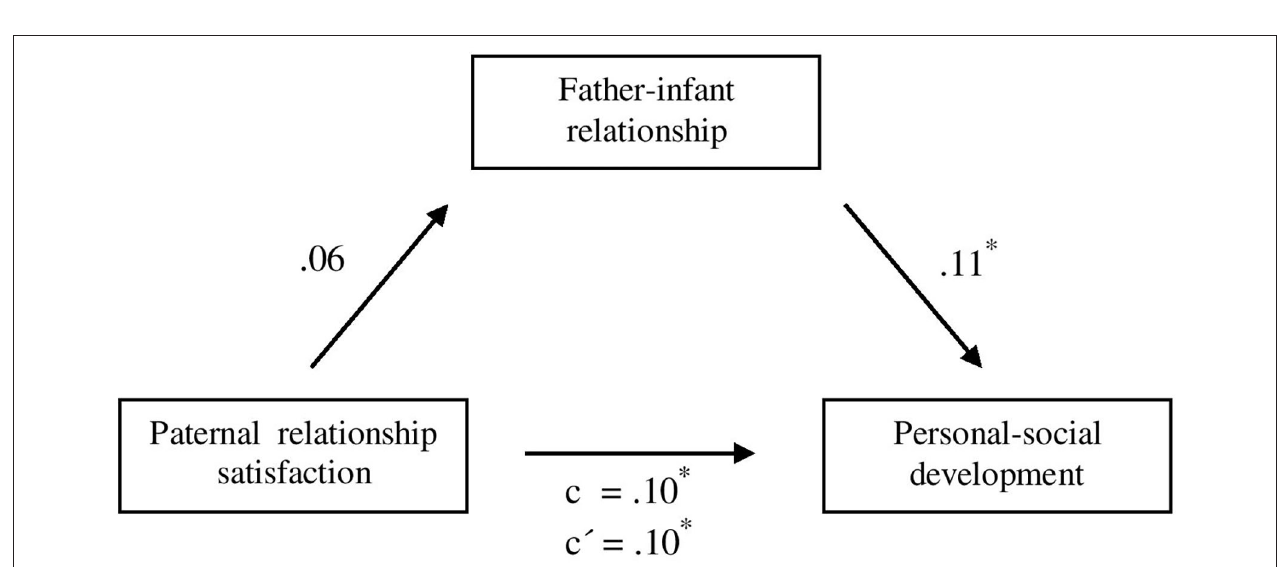
FIGURE 2 | Mediation analysis for the prospective association of paternal relationship satisfaction on infant personal-social development, mediated by father-infant relationship, controlling for parental age, education, infant gender, infant health, premature birth and depression. Specification of the standardized regression coefficients ( β ); c = total effect; c ′ = direct effect. * p < 0.05. ** p < 0.01. N = 583–585.